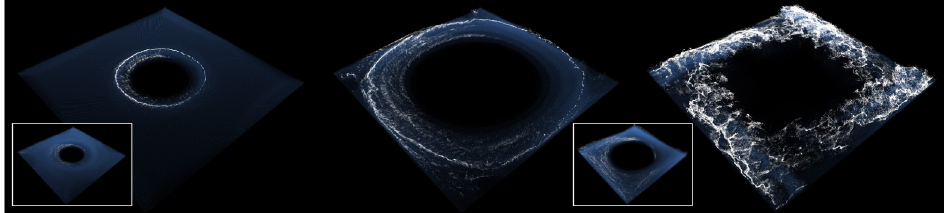
Fig 23. Experimental results by applying our method to the angular advection method of foam particles [69] (inset image: Without angular momentum based advection [22, 23]).